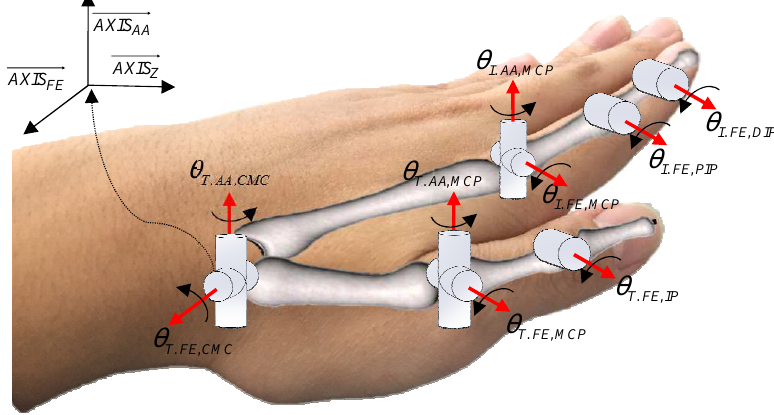
Figure 9. Proposed model for the finger